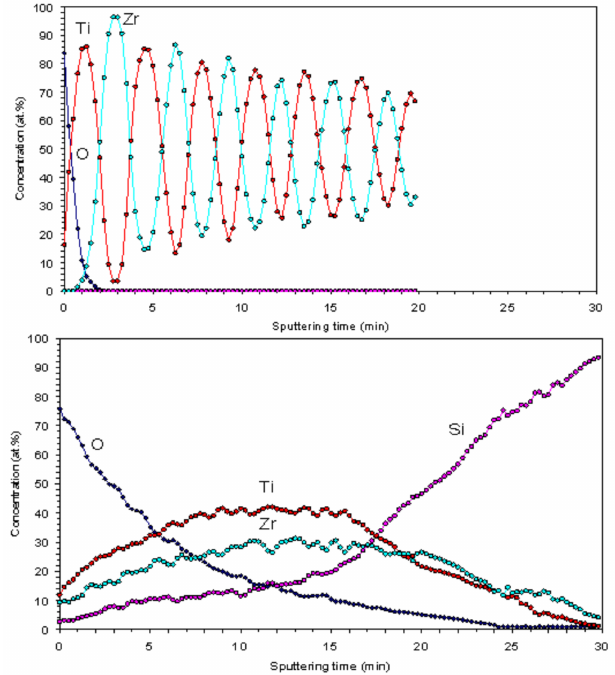
Figure 4. Auger electron spectroscopy (AES) spectra before ( Top ) and after ( Bottom ) laser modification of the 15 × (Ti / Zr) / Si multilayer thin